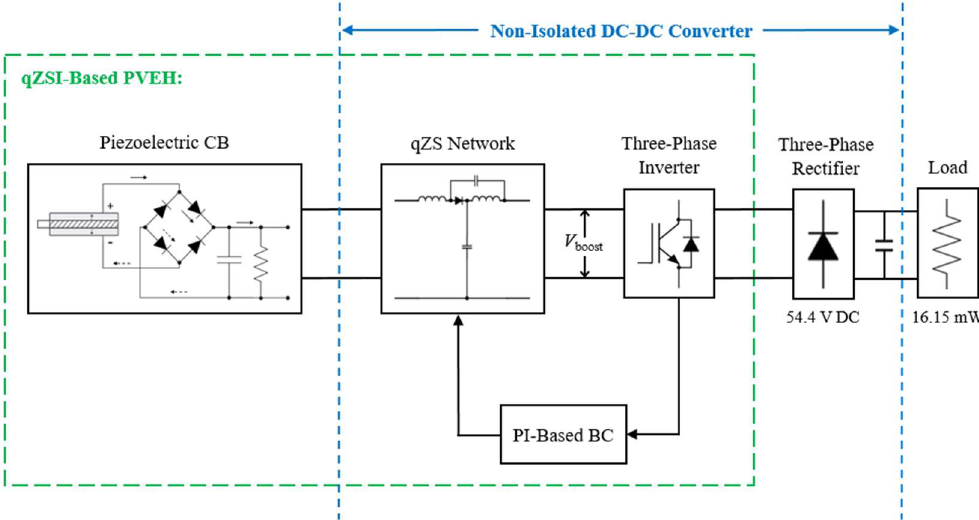
Figure 7. Block diagram of the proposed SPDS.